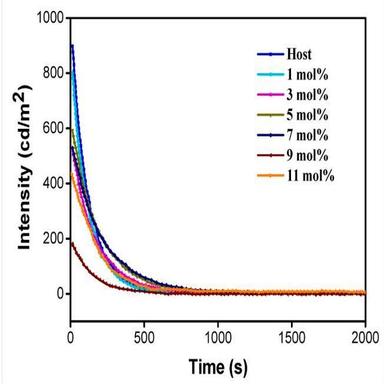
Decay curve for the prepared samples.